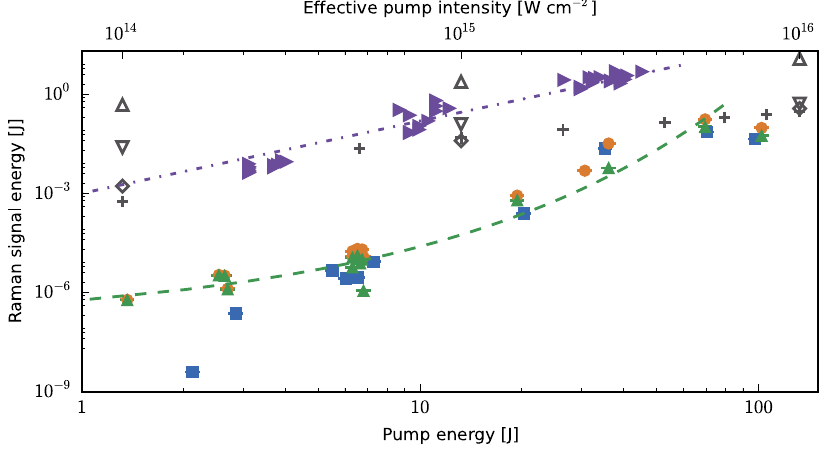
Figure 1. Measured and numerically calculated Raman signal energies. Experimental (numerical) results are shown by filled (empty, gray) symbols. (Blue) square: N-RS; (orange) circle: S-RS + N-RS; (green) up-pointing triangle: S-RS with the (green) dashed line showing an exponential fit with respect to the square root of the pump energy. For comparison, results from simulations are shown. Cross: results from Leap. down-pointing triangle: OSIRIS simulations; Diamond: cplPIC simulations. The effective pump intensity is an estimated value used to enable comparison between experimental and simulation results. See Methods for details. Measured Raman signal energies backscattered along the pump axis are presented (right-pointing, purple triangle) in addition to results from OSIRIS simulations for a 2.6 mm long plasma (up-pointing triangle). (Purple) dash-dot line: power law fit to on-axis scattering data with exponent 2.2. Note that the horizontal lines across the symbols are error